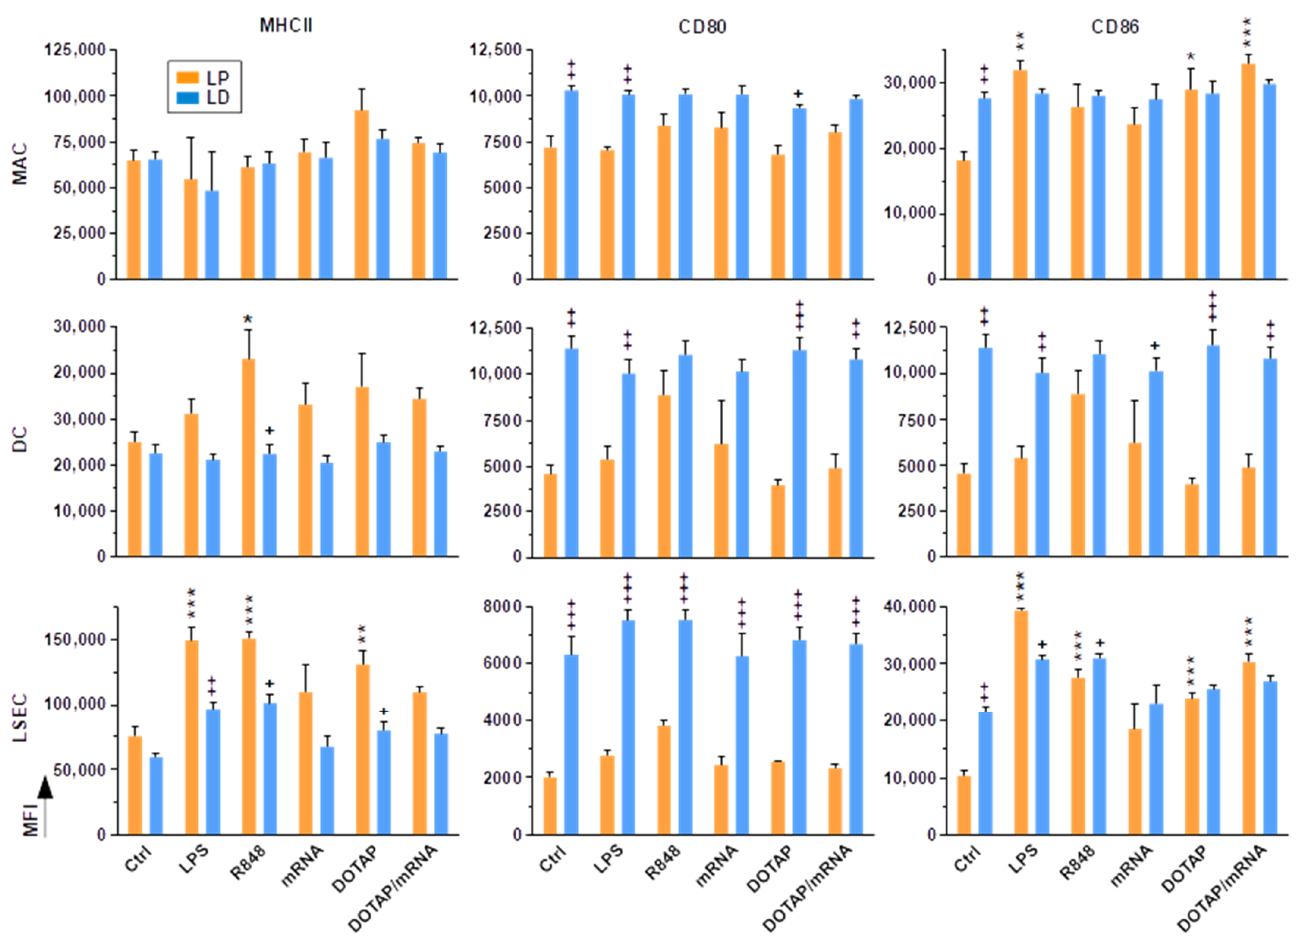
Figure 3. LD-enriched liver NPCs are pre-activated, as deduced from elevated activation marker expression. Liver NPCs enriched by LP and LD were seeded into wells of 96 well plates (10 5 /100µL) and stimulated overnight with the agents indicated or left untreated. The man fluorescence intensity (MFI) of surface markers was assessed by flow cytometry (mean ± SEM, n = 4). Statistically significant differences versus *according Ctrl and versus + LP are indicated (one way ANOVA, Tukey test). * , + p < 0.05, ** , ++ p < 0.01, *** , +++ p < 0.001.